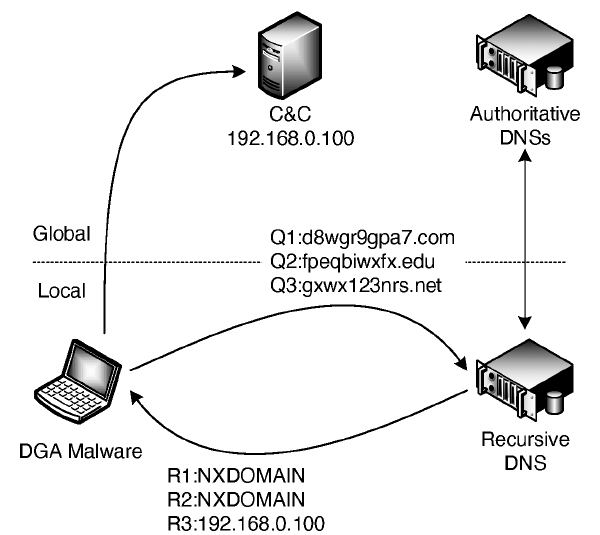
Figure 1. Callback communication between DGA malware and